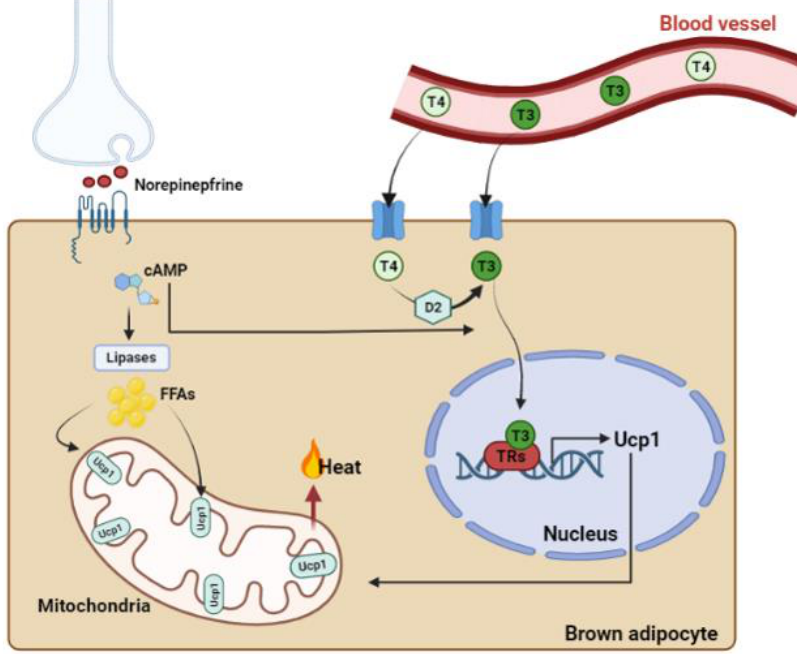
Figure 2. Thermogenic control of brown adipocytes by UCP1. Sympathetic neurons release synap- tic norepinephrine that binds to β-adrenergic receptors, stimulating the production of cAMP by adenylate cyclase. The sympathetic signal activates transcription factors and coactivators involved in the regulation of DIO 2. Both adrenergic signaling and TRs regulate UCP1 expression. Lipases break down triglycerides into free fatty acids, which are then transported to mitochondria and activate UCP1. UCP1 uncouples ATP production from respiration, causing an increase in mitochondrial activity and generating heat. The figure was created with Biorender.com.